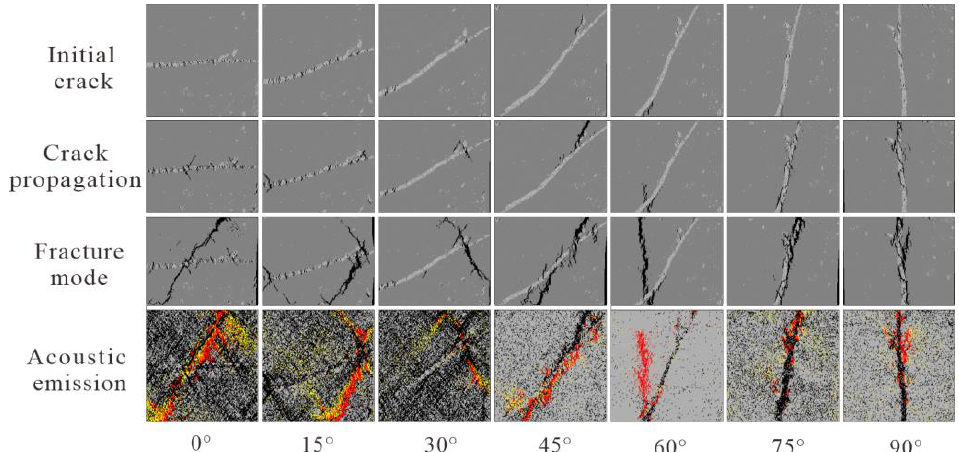
Figure 7. Fracture process and acoustic emission diagram of coal at different azimuth angles.